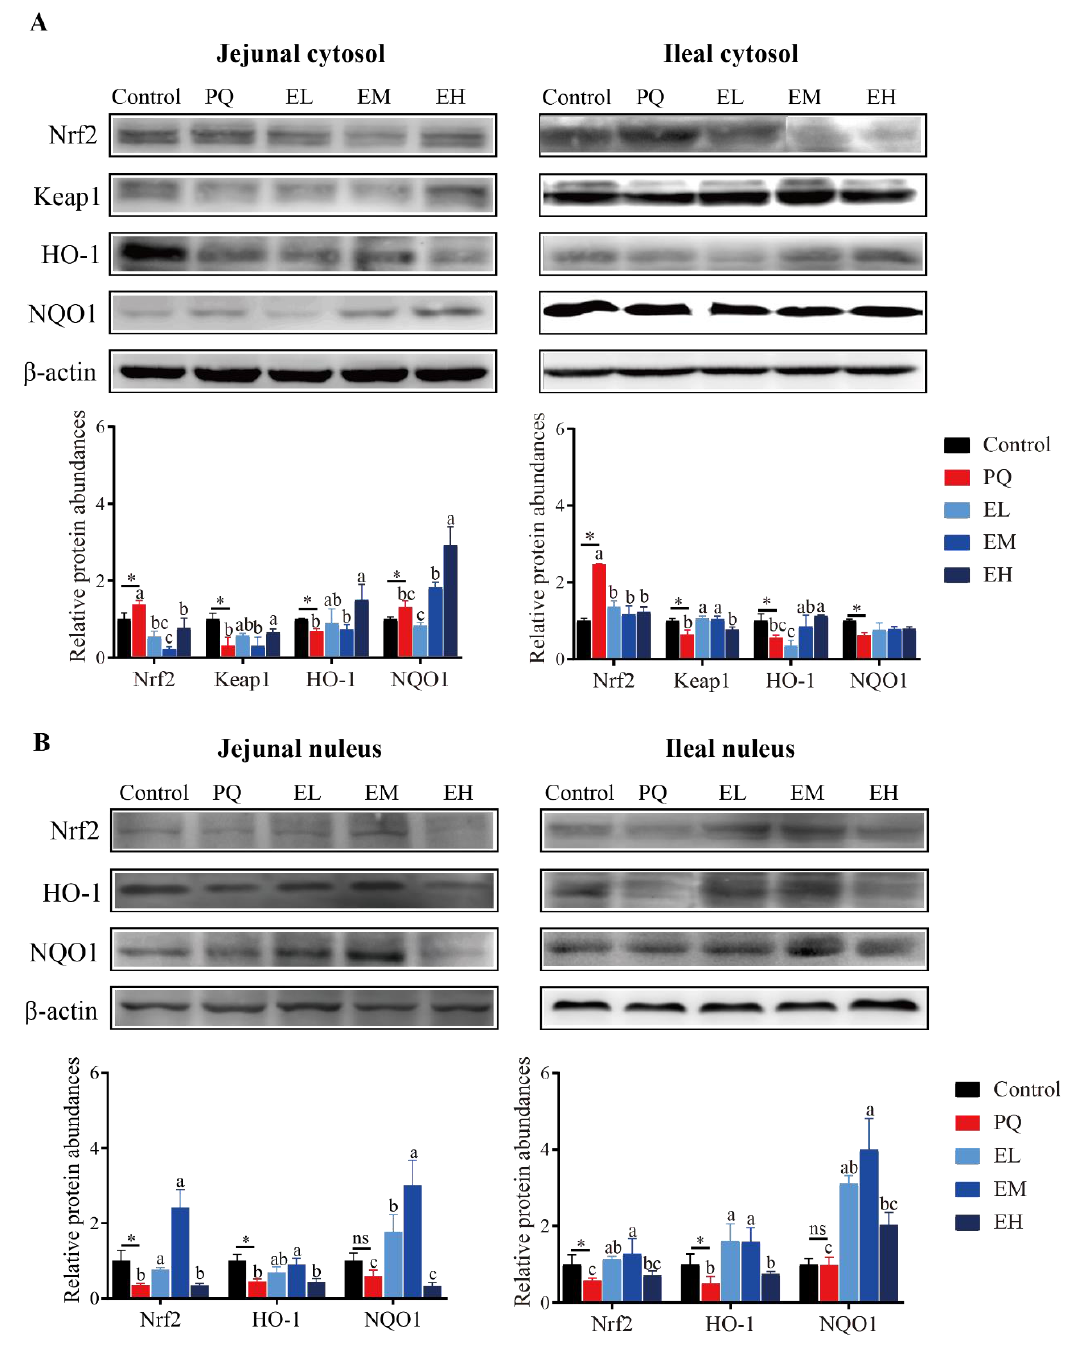
Figure 2. Protein abundances of Nrf2 signaling pathway of cytosol and nucleus of jejunal and ileal mucosa in piglets. ( A ) Nuclear factor erythroid 2-related factor 2 (Nrf2), Recombinant Kelch Like ECH Associated Protein 1 (Keap1), heme oxygenase-1 (HO-1), and quinone oxidoreductase 1 (NQO1) protein abundances in cytosol of jejunal and ileal mucosa. ( B ) Nrf2, HO-1, and NQO1 protein abundances in nucleus of jejunal and ileal mucosa. PQ = 4 mg/kg paraquet; EL = 0.005% ellagic acid + 4 mg/kg paraquet; EM = 0.01% ellagic acid + 4 mg/kg paraquet; EH = 0.02% ellagic acid + 4 mg/kg paraquet. n = 8. Data are shown as mean ± SEM. * means the difference was significant when compared to the control group. ns means the difference was not significant when compared to the control group. a – c Values with different lowercase letters are significantly different among PQ, EL, EM, and EH groups ( p < 0.05).